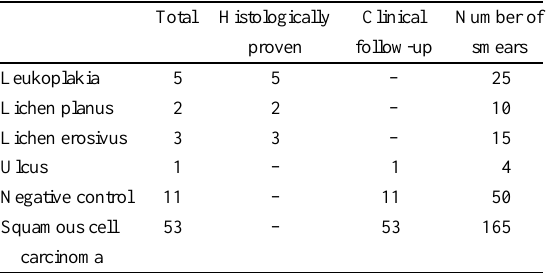
Synopsis about clinical or histological diagnoses and number of smears of all oral lesions ( n = 75) Total Histologically Clinical Number of